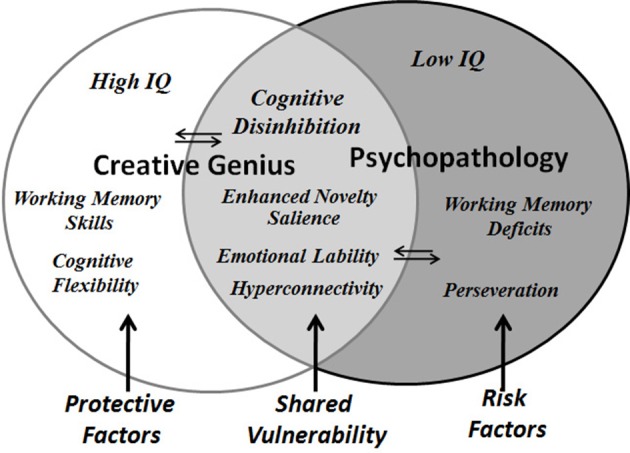
Shared vulnerability model of creativity and psychopathology (adapted from Carson, 2011).